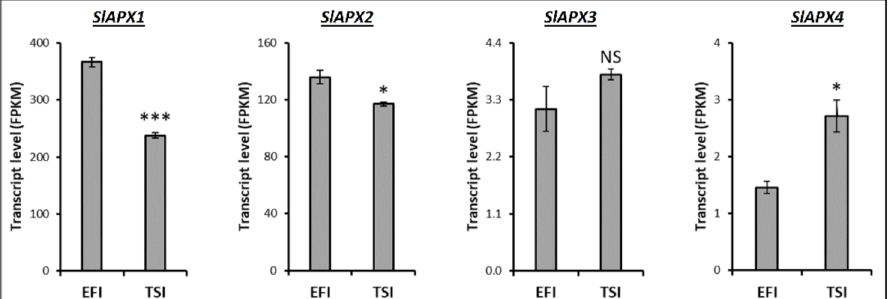
Figure 9. Effect of top sprinkle (TSI) and ebb-and-flow (EFI) irrigation on transcript profiling of APX genes in tomato root. Vertical bars indicate means ± SE (3 biological and 3 techincal replicates). The * and *** represent significance at p ≤ 0.05 and p ≤ 0.001, respectively, according to Student’s t -test. NS–not significant.